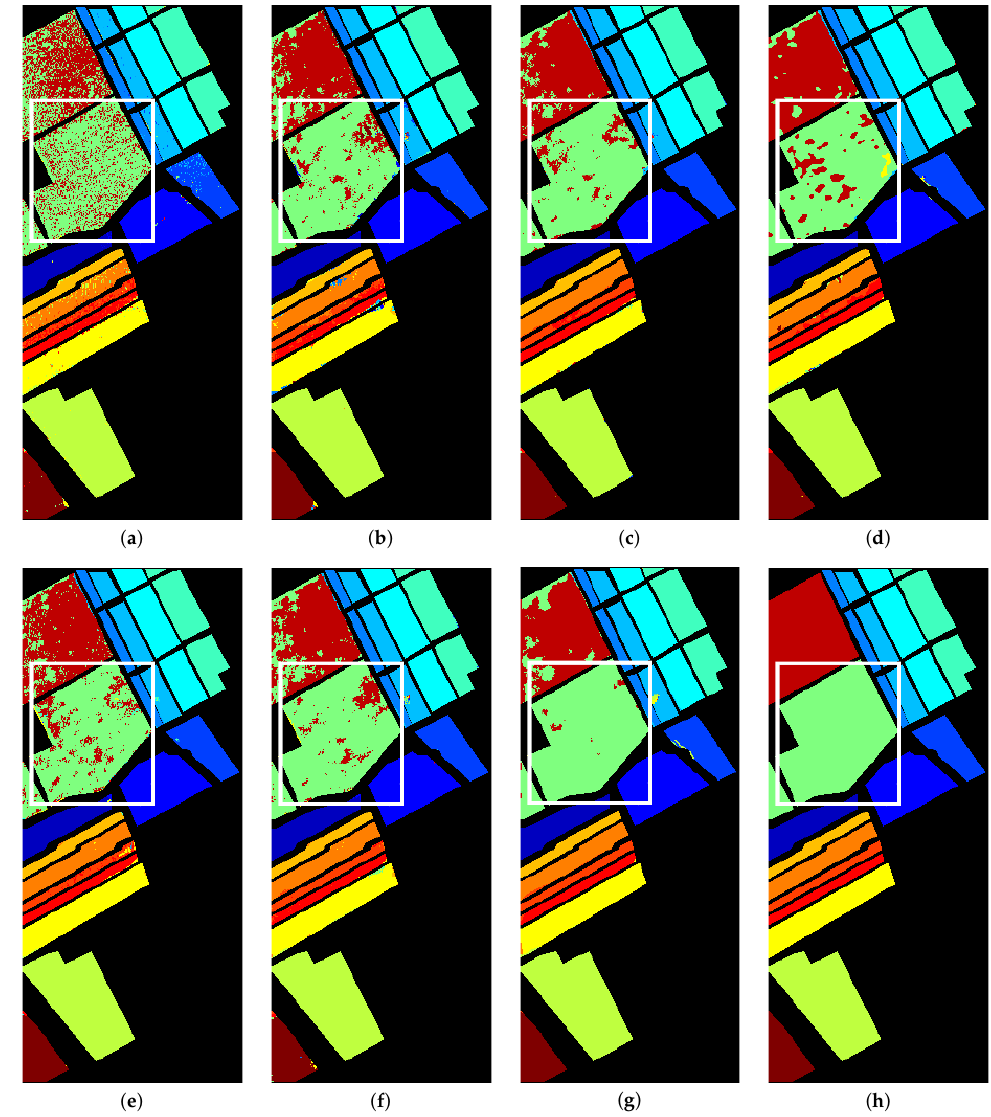
Figure 8. Classification maps for Salinas SA. ( a ) SVM; ( b ) 2D-CNN; ( c ) 3D-CNN; ( d ) HybridSN;